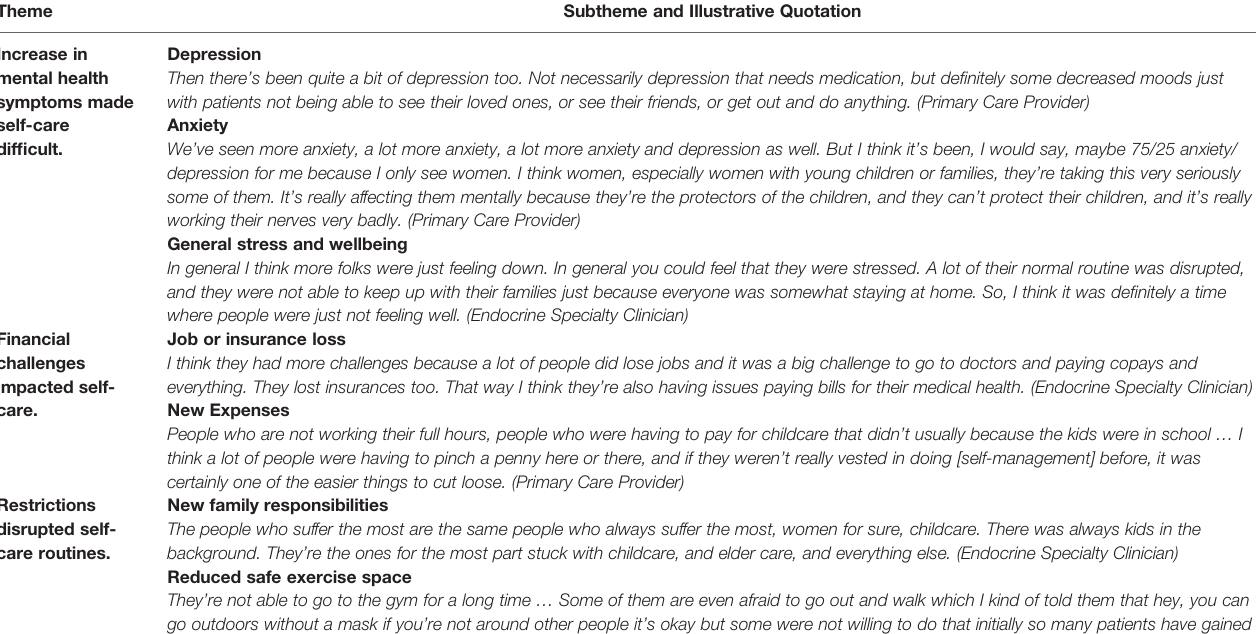
TABLE 3 | COVID-19 impacts on self-management.